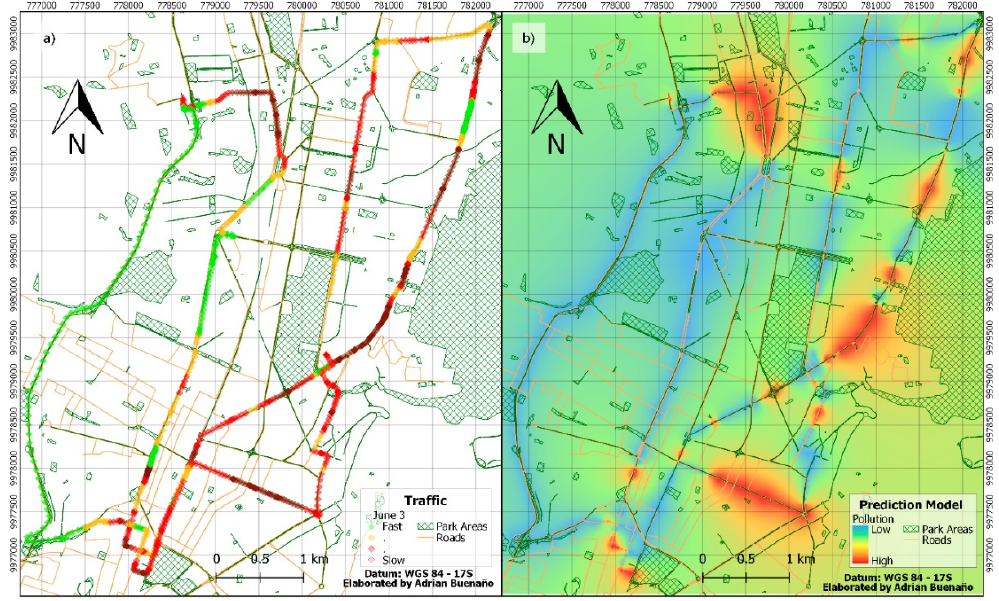
Table 2. Comparing the different models in terms of overall average within-cluster distance. The first three models are the ones obtained from traffic (columns 2–4). The last four models are the ones built from traffic and the time of day (columns 5–8).